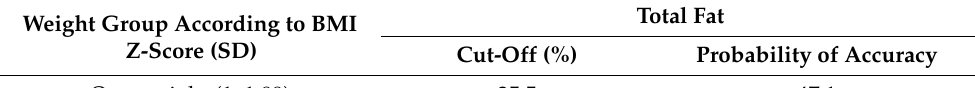
Table 1. Optimal cut-off points for fat percentage that differentiate weight groups according to BMI Z-score. Weight Group According to BMI Z-Score (SD) Overweight (1–1.99)